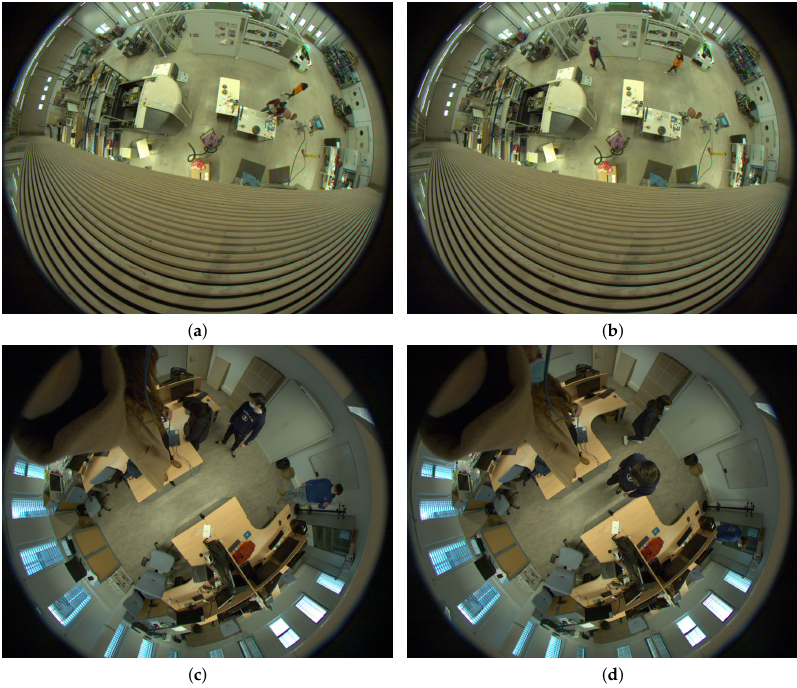
Figure 4. Extracted frames from videos 2 and 3 with two and three persons respectively. ( a ) Video 2, frame 194. ( b ) Video 2, frame 494. ( c ) Video 3, frame 94. ( d ) Video 3, frame